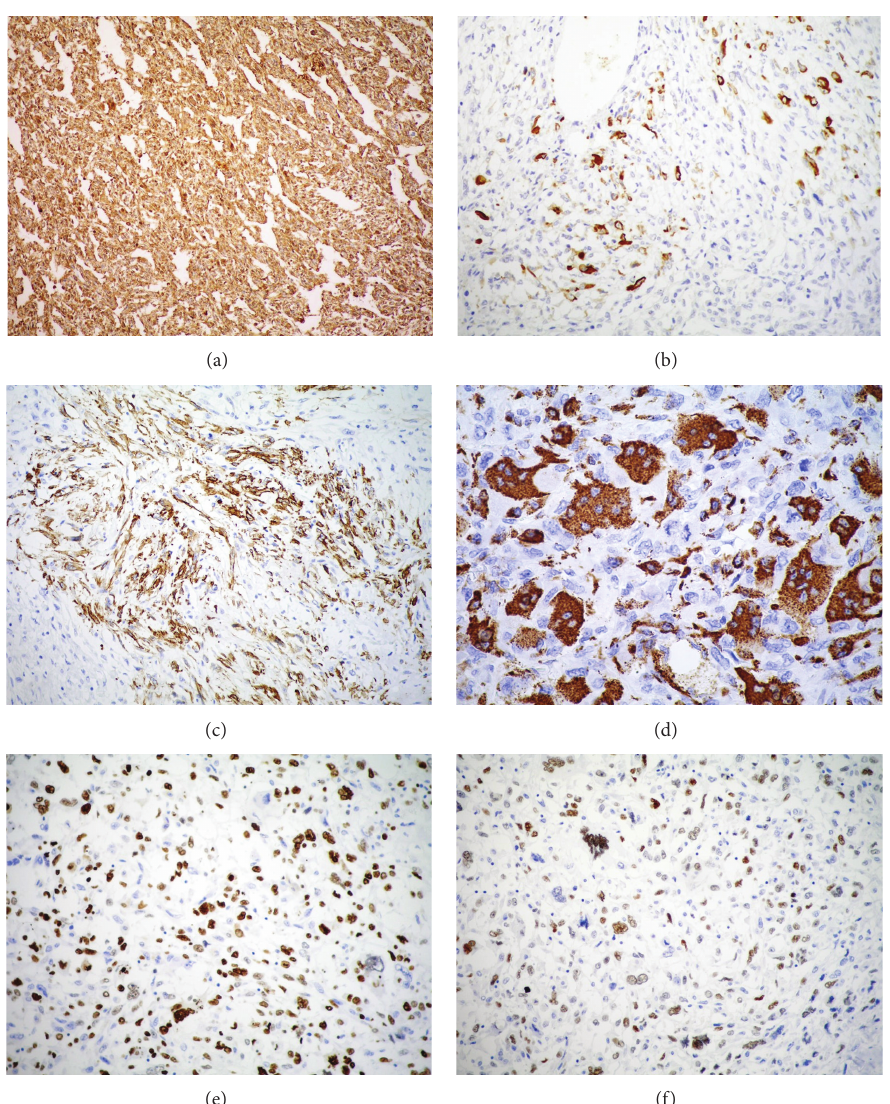
Figure 3: Immunoreactivity of metaplastic carcinoma. (a) Strong immunoreactivity for vimentin in the sarcomatous component. (b) Immunoreactivity for cytokeratin AE1/AE3 is present in few cells of the sarcomatous component. (c) Reactivity for smooth muscle actin in focal area. (d) Immunoreactivity for CD68 in osteoclast-like cells. (e) Nuclear immunoreactivity for Ki-67. (f) Expression of p53 (polymer- HRP detection system,